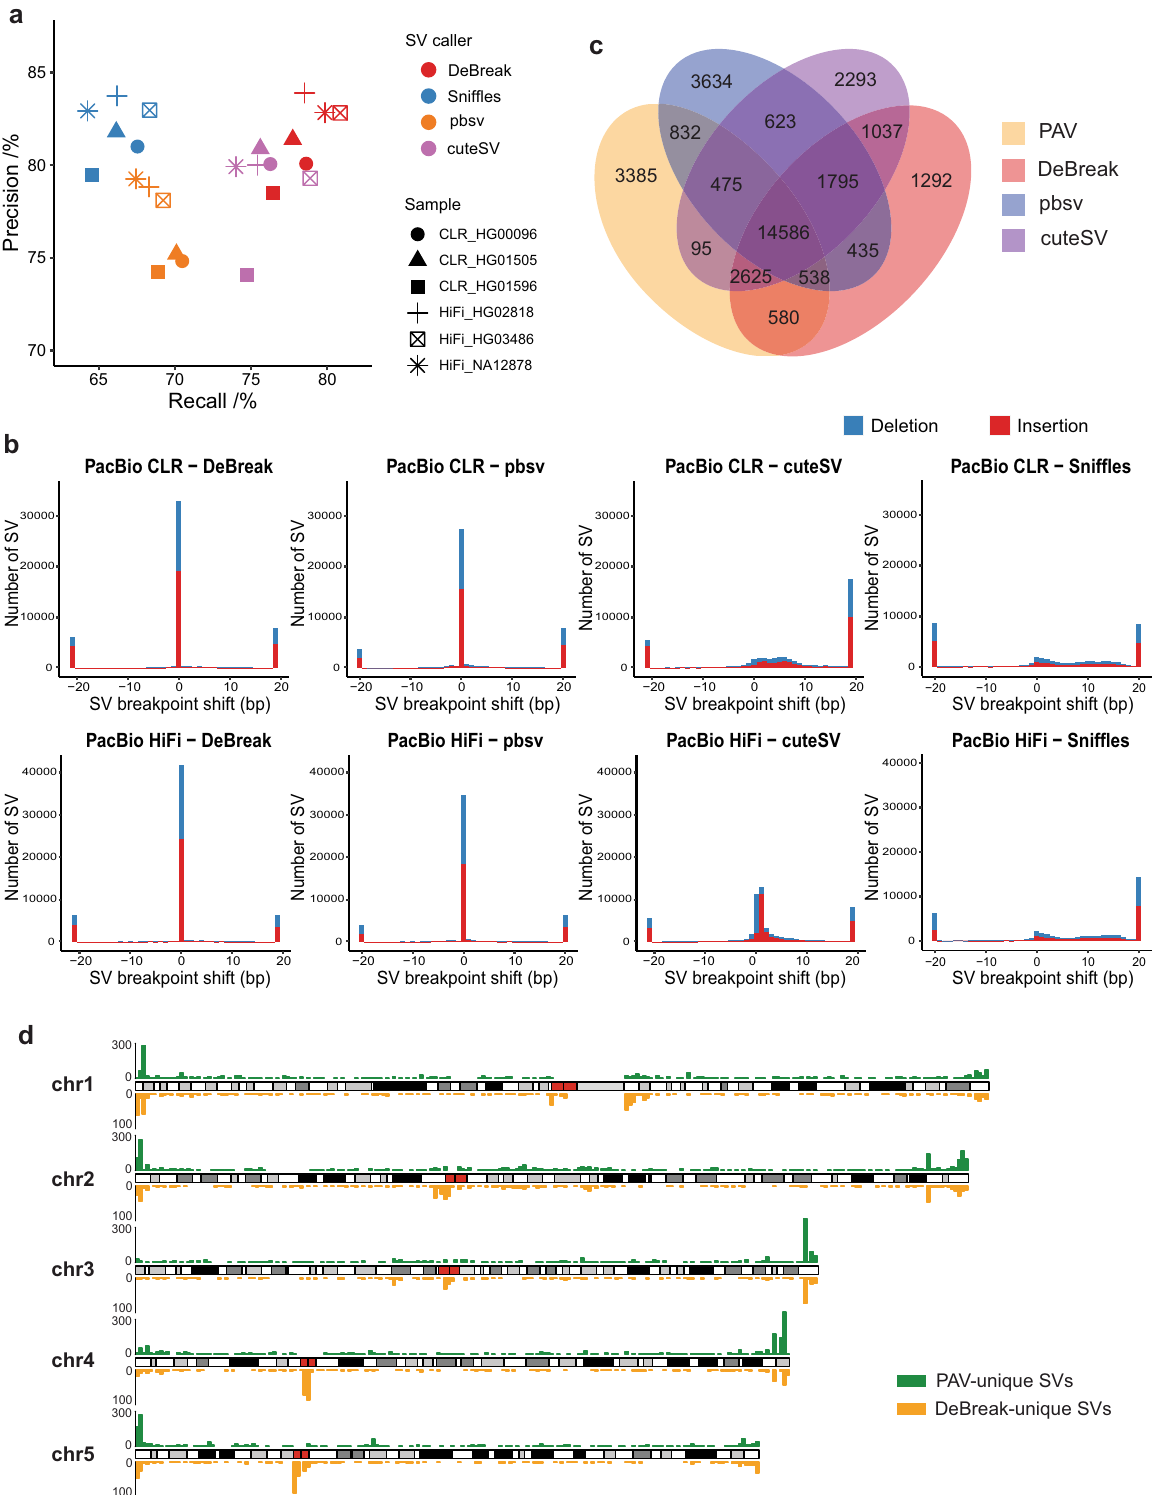
Fig.3|Alignment-basedandassembly-basedSVdiscovery.a SVdiscoveryrecall and precision of alignment-based SV callers when compared with the assembly- basedSVcallset. b SVbreakpointaccuracyofDeBreak,pbsv,cuteSV,andSnif fl esin PacBio CLR (top) and HiFi (bottom) datasets. c Venn diagram showing the overlap